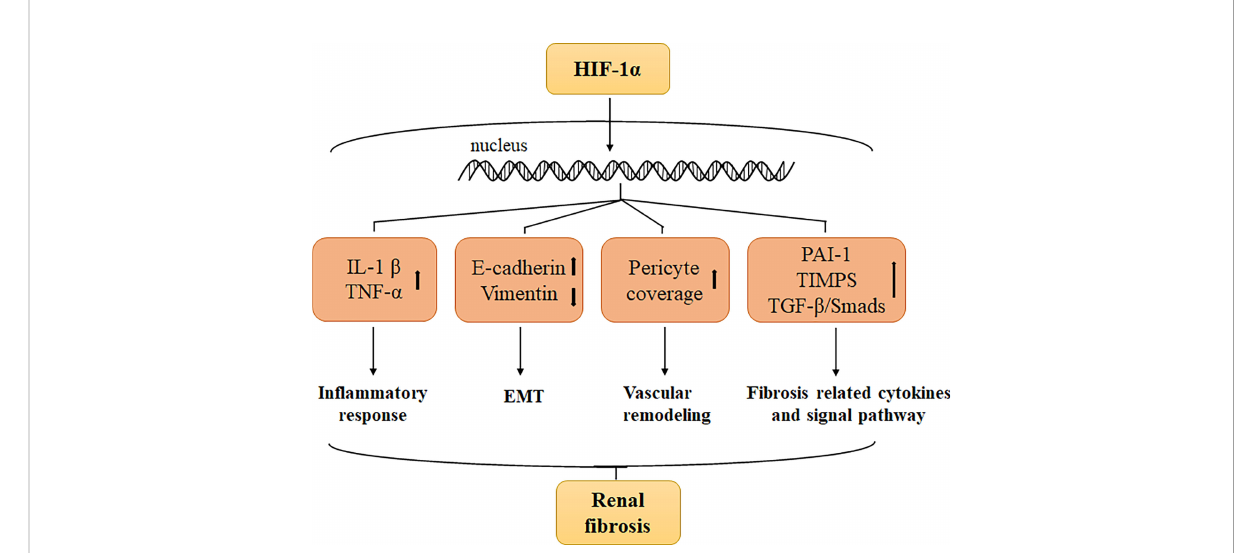
FIGURE 1 HIF-1 a expression increases under hypoxia, which promoted renal fi brosis through the following aspects: Stimulating the secretion of interleukin-1 b (IL-1 b ) and tumor necrosis factor- a (TNF- a ), and increasing the in fl ammatory reaction, upregulation of the epithelial cell marker E-cadherin and downregulation of the mesenchymal marker vimentin promote EMT, enhance pro- fi brosis cytokines such as plasminogen activator inhibitor 1 (PAI-1) and tissue inhibitor of metalloproteinase (TIMPs), and regulate fi brosis-related signaling pathways such as TGF- b / Smads